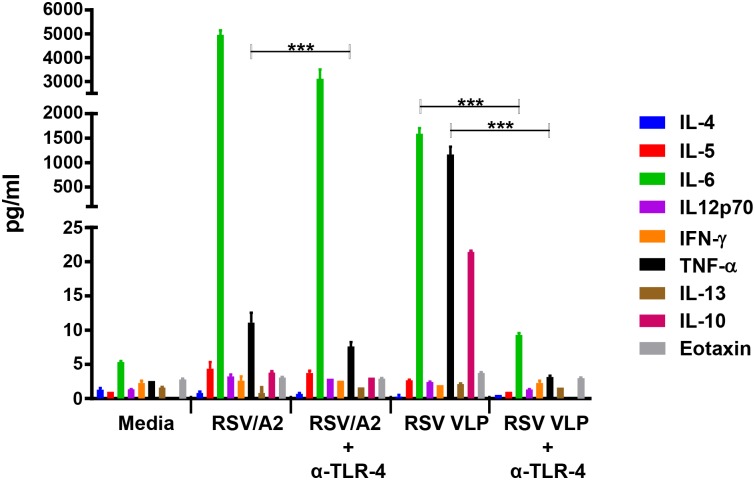
RSV A2 and RSV VLP-induced cytokines IL-4, IL-5, IL-13, IL-10, IL12p70, IFN-ү, TNF-α and IL-6, and eotaxin, and the role of TL4 in their induction: PMA stimulated THP-1 cells were treated with RSV or RSV VLPs in presence or absence of anti-TLR-4 antibody.Both the virus and the VLPs upregulated Th1 cytokine TNF-α and proinflammatory cytokine IL6 while Th2 cytokines IL4, IL5 and IL-13 as well as eotaxin were not elevated. IL-10 was in the lower range. TLR-4 blockade reduced the production of TNF-α, IL-6 and IL-10. 2-way ANOVA: ***p<0.0001